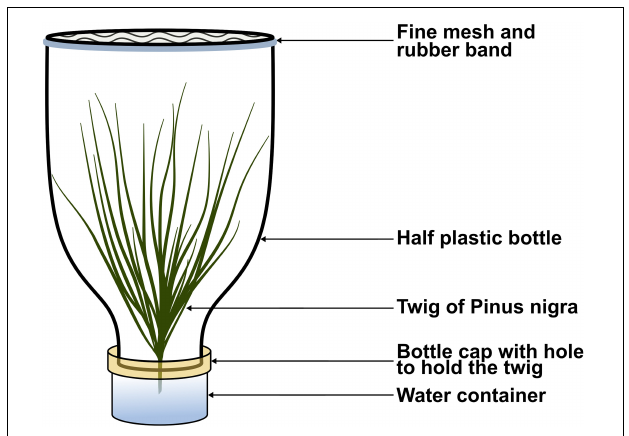
FIGURE 3 | Custom made container for larval development. “Pine leaf” icon by António Ascensão, from thenounproject.com.